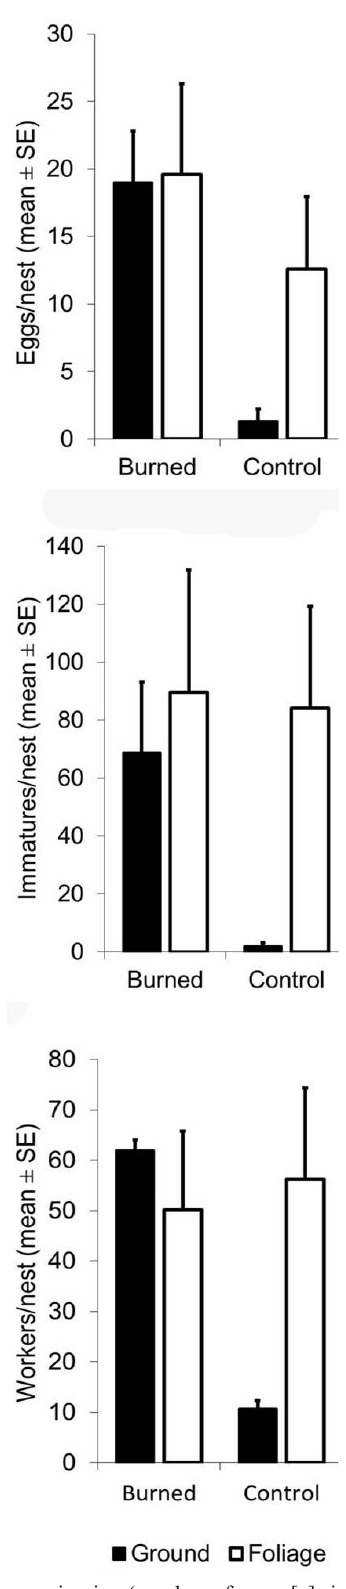
Fig 3 . Differences in size (number of eggs [a], immature [b] and workers [c]) of colonies established in artificial cavities placed on the ground and foliage of burned and recovered areas of Cerrado. Colonies established in cavities placed on the ground grew less in control areas (p = 0.001 for all variables), but no difference occur for nests in cavities on the foliage. In general, colonies of burned areas present higher number of individuals (p = 0.0001 for all